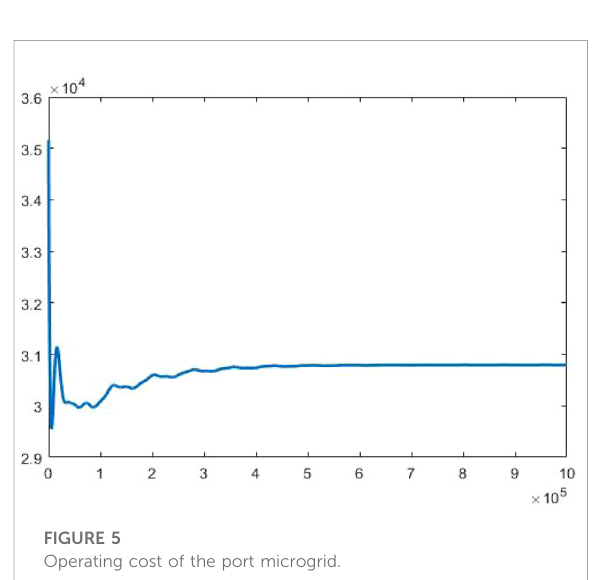
FIGURE 5 Operating cost of the port